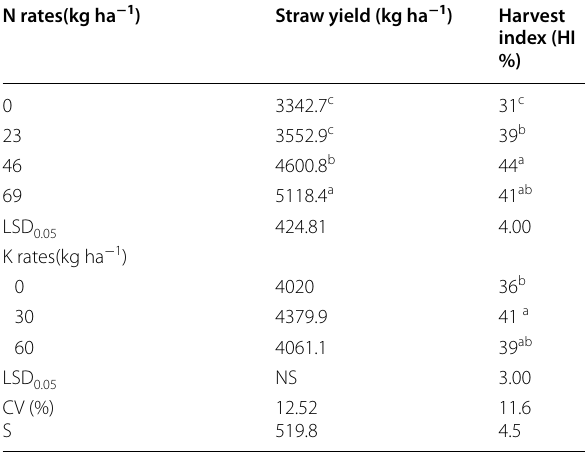
Table 5 Straw yield (kg/ha) and Harvest index as affected by N and K fertilizer rates